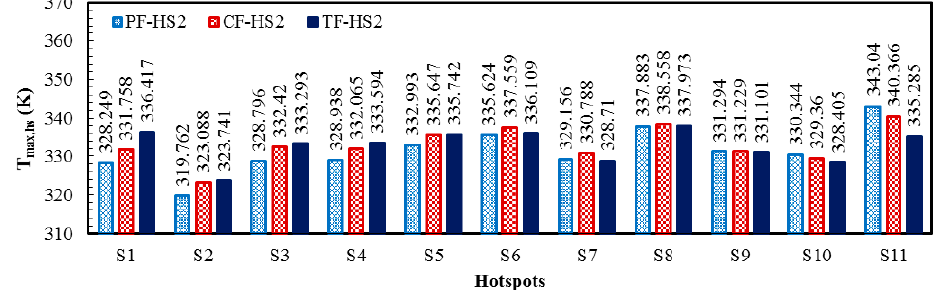
Figure 10. Maximum temperatures at the hotspots of PF, CF, and TF heat sinks with the hotspot scheme HS2 at the total flow rate of 0.01 kg/s.